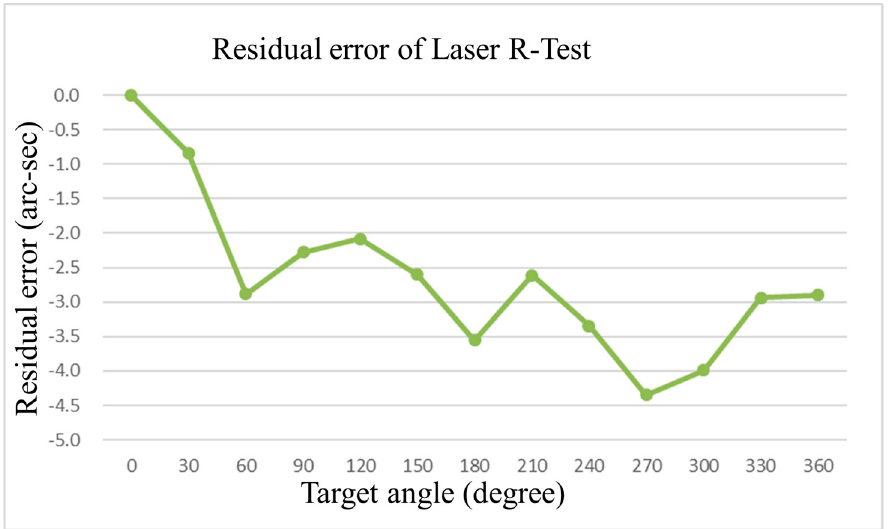
Figure 24. Residual error of Laser R-test.